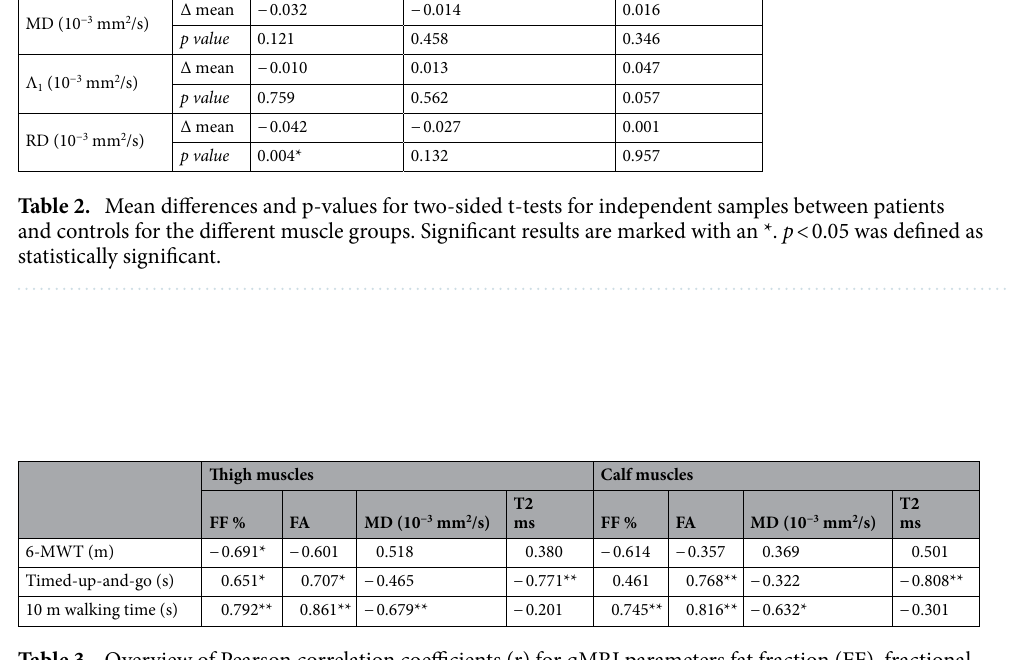
Table 3. Overview of Pearson correlation coefficients (r) for qMRI parameters fat fraction (FF), fractional anisotropy (FA), mean diffusivity (MD), and T2 relaxation time (T2) and clinical outcome measures